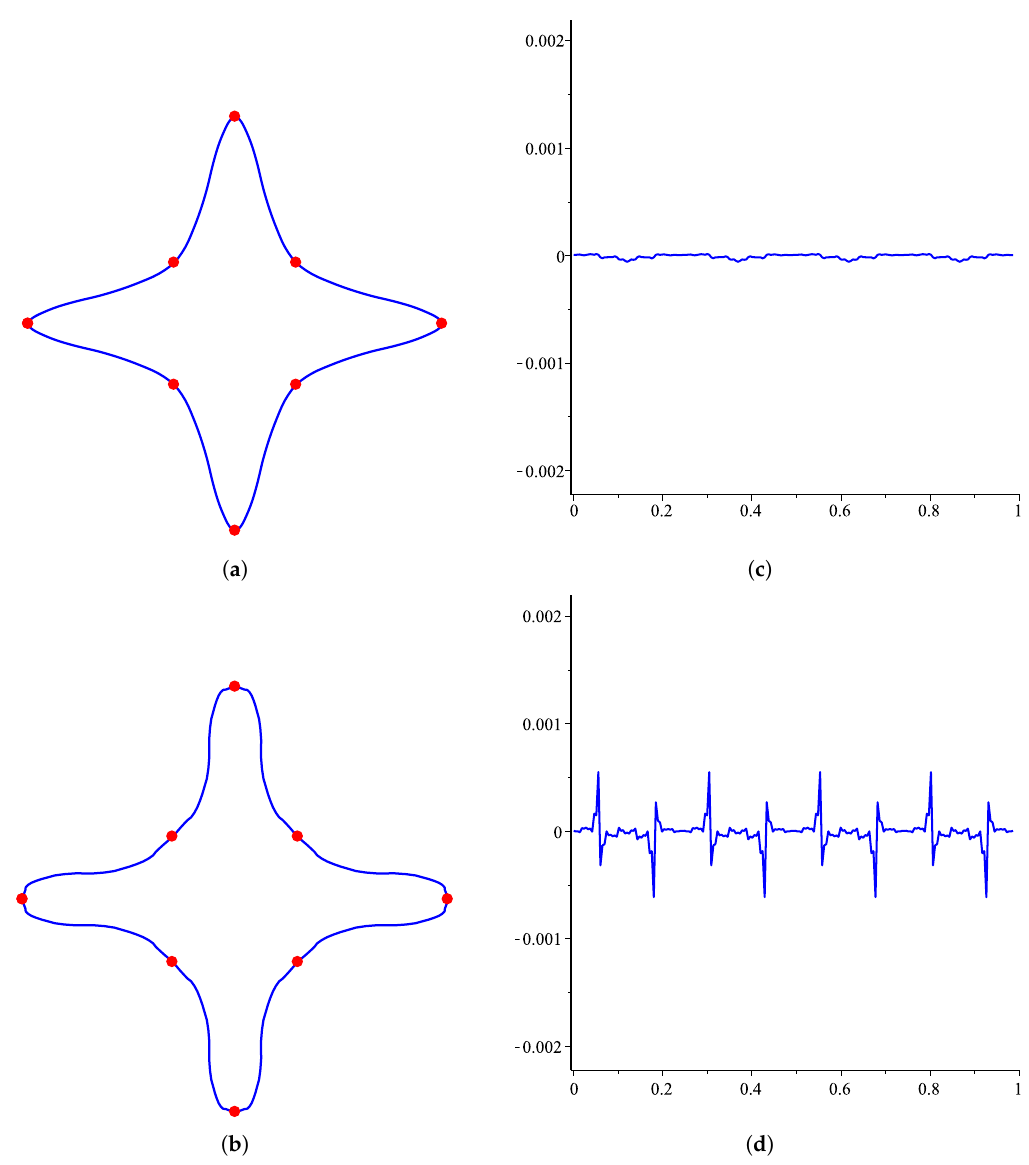
Figure 3. Results for various choices of the parameter u are shown on the left together with their corresponding curvature on the right. From top to bottom: u = 0 and 0.0074. ( a ) Limit curve at u = 0; ( b ) Limit curve at u = 0.0074; ( c ) Curvature plot of ( a ); ( d ) Curvature plot of ( b